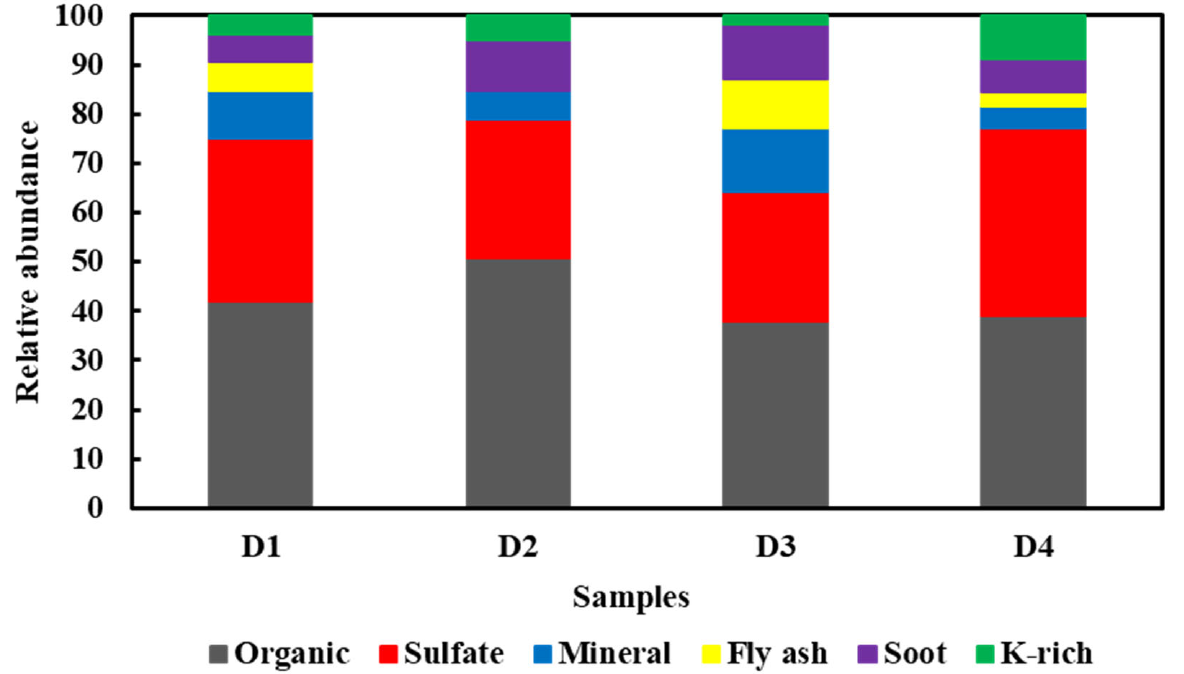
Figure 6. Relative abundance of different particle types in daily samples of the winter haze in Xi’an during the sampling period.